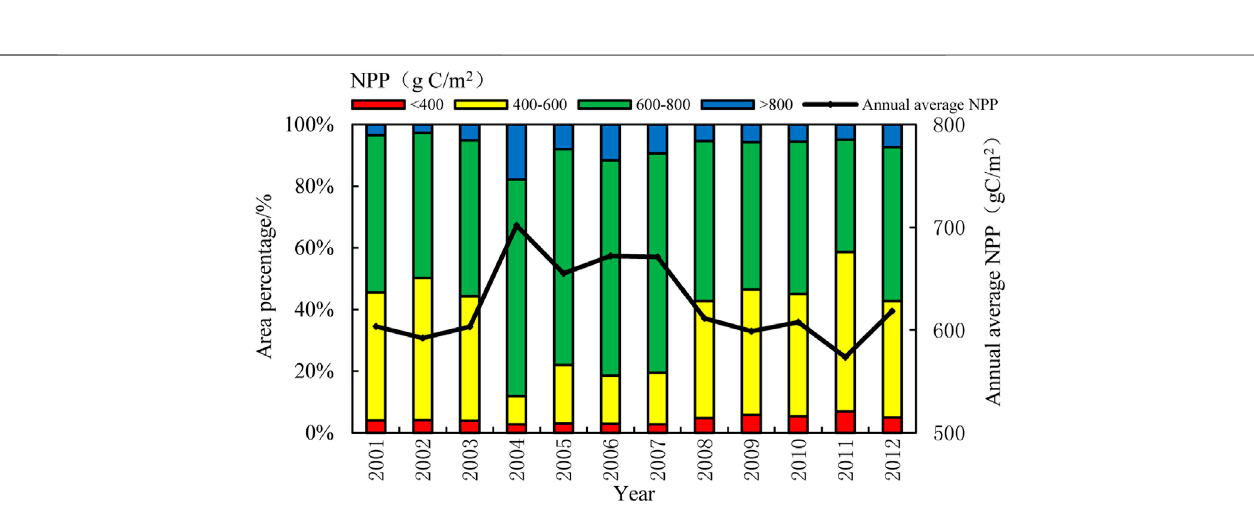
FIGURE4|(A) SpatialdistributionofthemeanannualNPP; (B) landcovertypesofHubeiProvinceandmeanNPP;and (C) percentageoffourNPPgradesforeight land cover types.